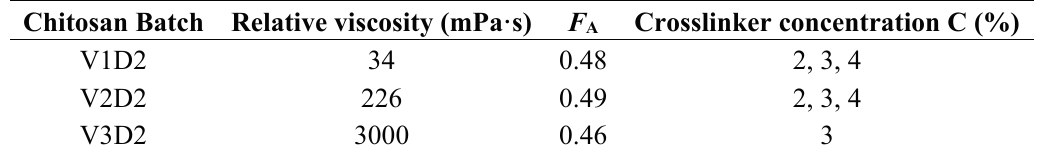
Table 2. Characteristics for the chitosans used in the long term storage experiment.